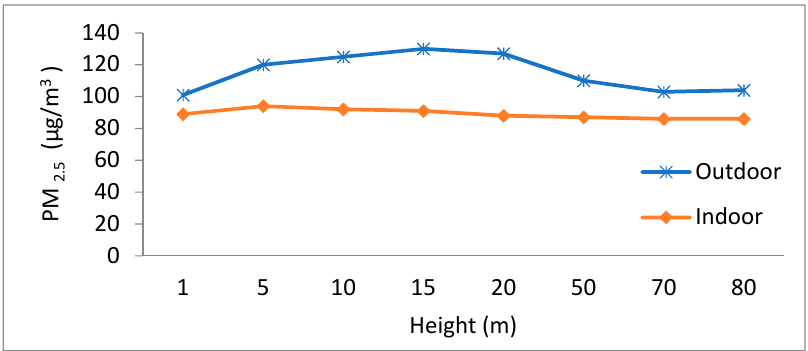
Figure 19. Effect of the node deployment height on PM 2.5 concentration. Figure 20. Effect of the node deployment height on PM Figure 20. Effect of the node deployment height on PM 2.5 concentration.